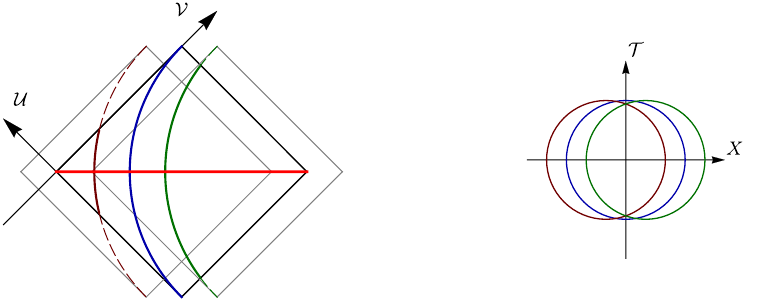
Figure 9. Schematic plot of the family of periodic instantons in Rindler spacetime ( left ) and their form in Euclidean time in Cartesian coordinates ( right ). Red line marks the surface at which the instanton is continued to real time. From left to right: the collapsing bubble (brown), the sphaleron (blue), the expanding bubble